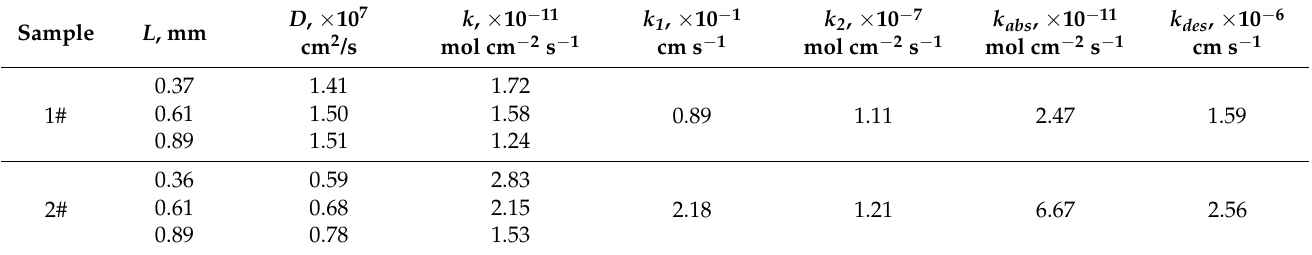
Table 2. Parameters of the hydrogen permeation experiments and the IPZ model.